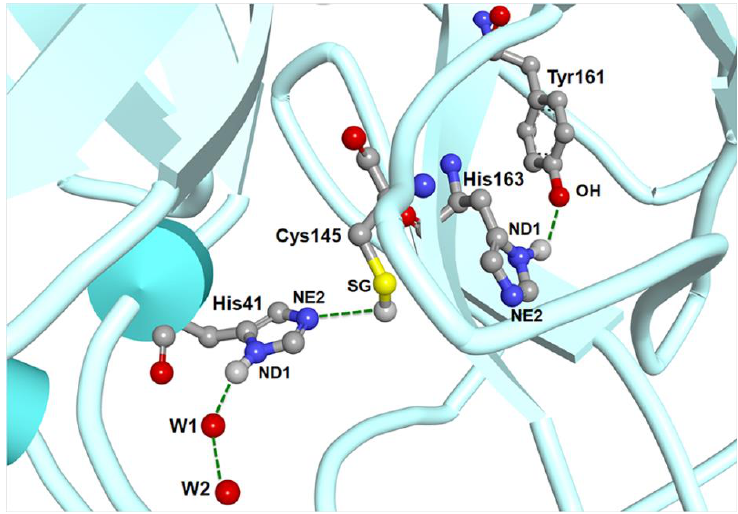
Figure 3. The interactions of W2---W1----ND1-His41-NE2---SH-(Cys145) are observed in the crystal structure of 6YB7. This recognition indicates the involvement of water molecules W1 and W2 with the catalytic region of Mpro. The –OH of Tyr161 stabilizes ND1 of His163 through H-bonding interaction. 0 In addition, the H-bonding interactions have been also observed between the –SH group of Cys145 and NE2 of His163 in energy minimized structures of 5RGL and 5REX. In detail, the H atom of the thiol group of Cys145 moves towards NE2 of His163 when NE2 of His41 is protonated as HSE, but the concern H atom is reversely moved towards NE2 of His41 when ND1of His41 is protonated as HSD. The superimposed energy minimized structures between HSD41 and HSE41 have indicated the change of orientation of the H atom of Cys145 from His163 to His41 (Figure 4). Hence, His163 may polarize and interact with the -SH group of Cys145 (in HSE41 state) and form a thiolate– imidazolium ion-pair, which may influence the inhibitor-binding propensity of this region. Possibly –OH of Tyr161 is found to stabilize the thiolate–imidazolium ion-pair through the formation of an H-bond with ND1 of His163 (energy minimized and crystal structure of 5RGL and 5REX).